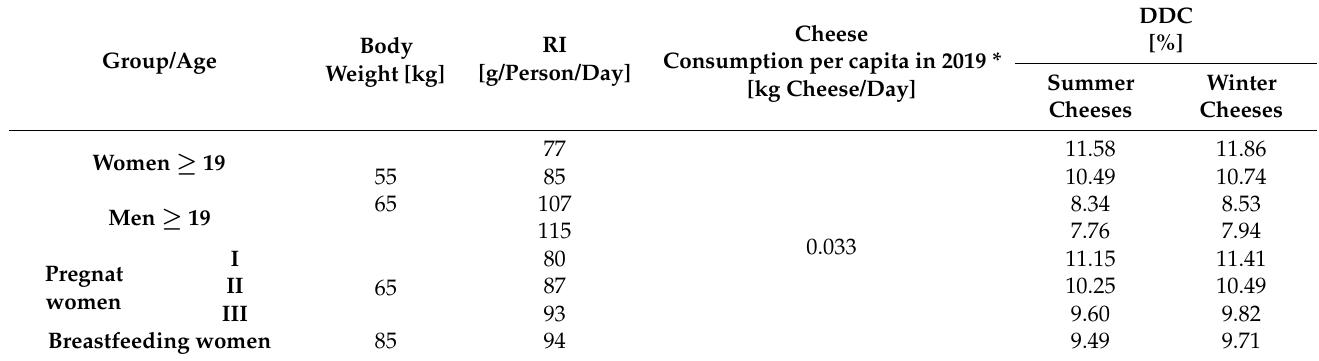
Table 2. Covering the daily fat requirements after eating a portion of